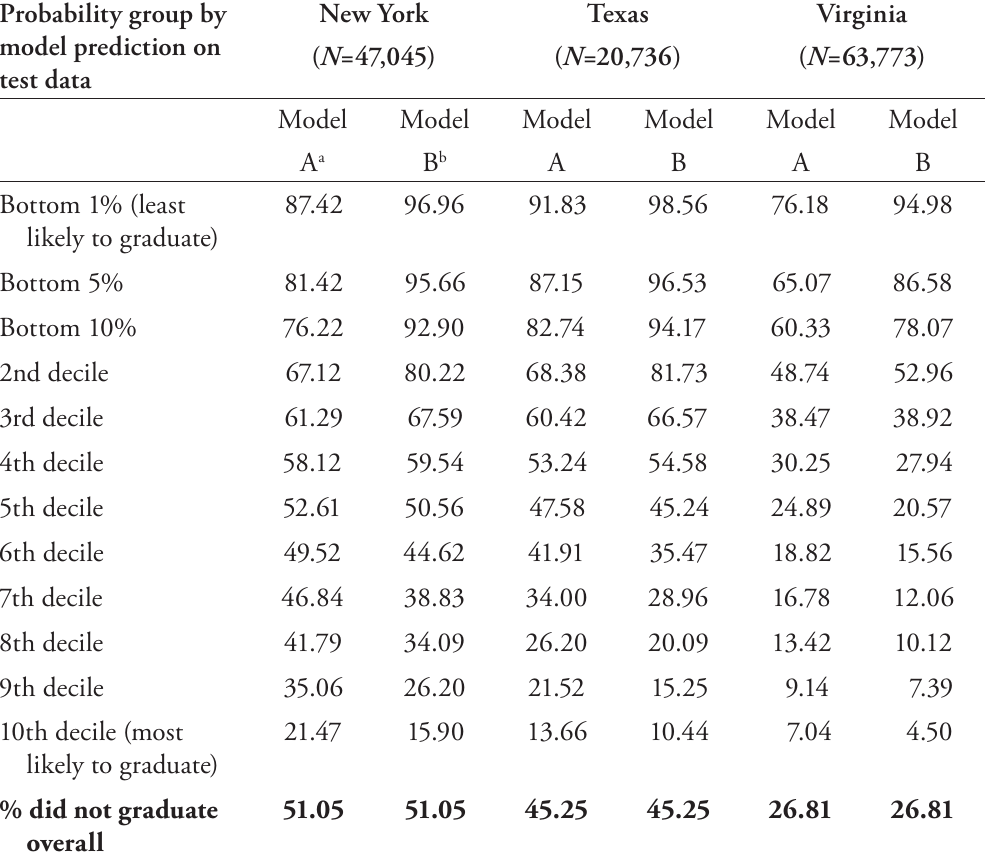
Table 3. BA Students’ Predicted Probability Distribution of Graduation by Actual % of Students that Did Not Graduate Probability group by model prediction